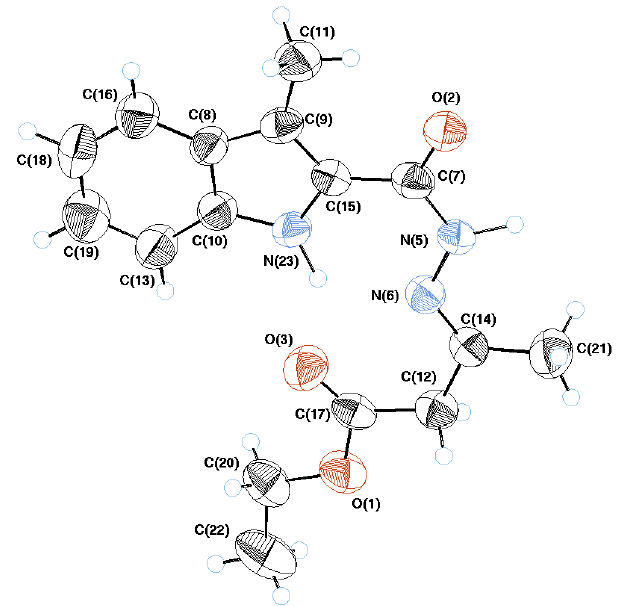
Figure 1. The X-ray crystal structure of compound 3